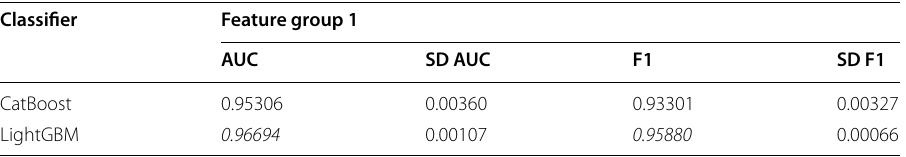
Table 20 Mean performance of CatBoost and LightGBM in terms of AUC and F1-score on datasets with features from feature group 1